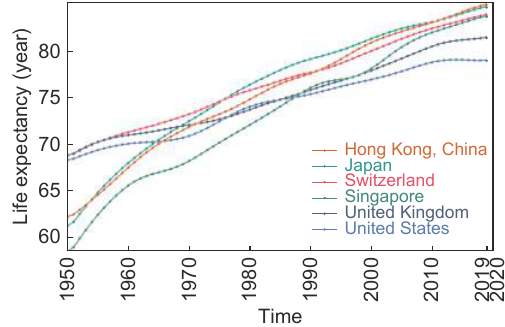
Fig. 2 Data visualization of life expectancy (1950 to 2019) from Our World in